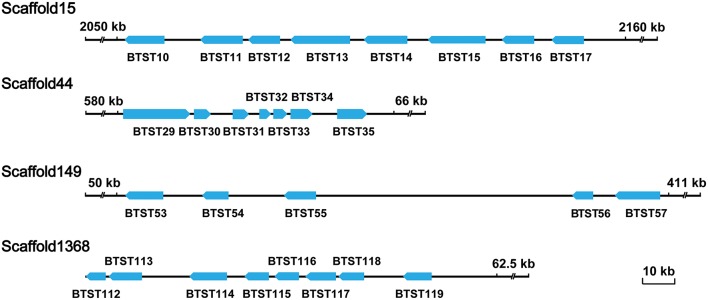
Location of tandem repeat BTSTs on scaffolds. The blue arrows indicate the transcriptional orientations of the BTSTs on the scaffolds. One BTST cluster was identified on each of four scaffolds (15, 44, 149, and 1,368).